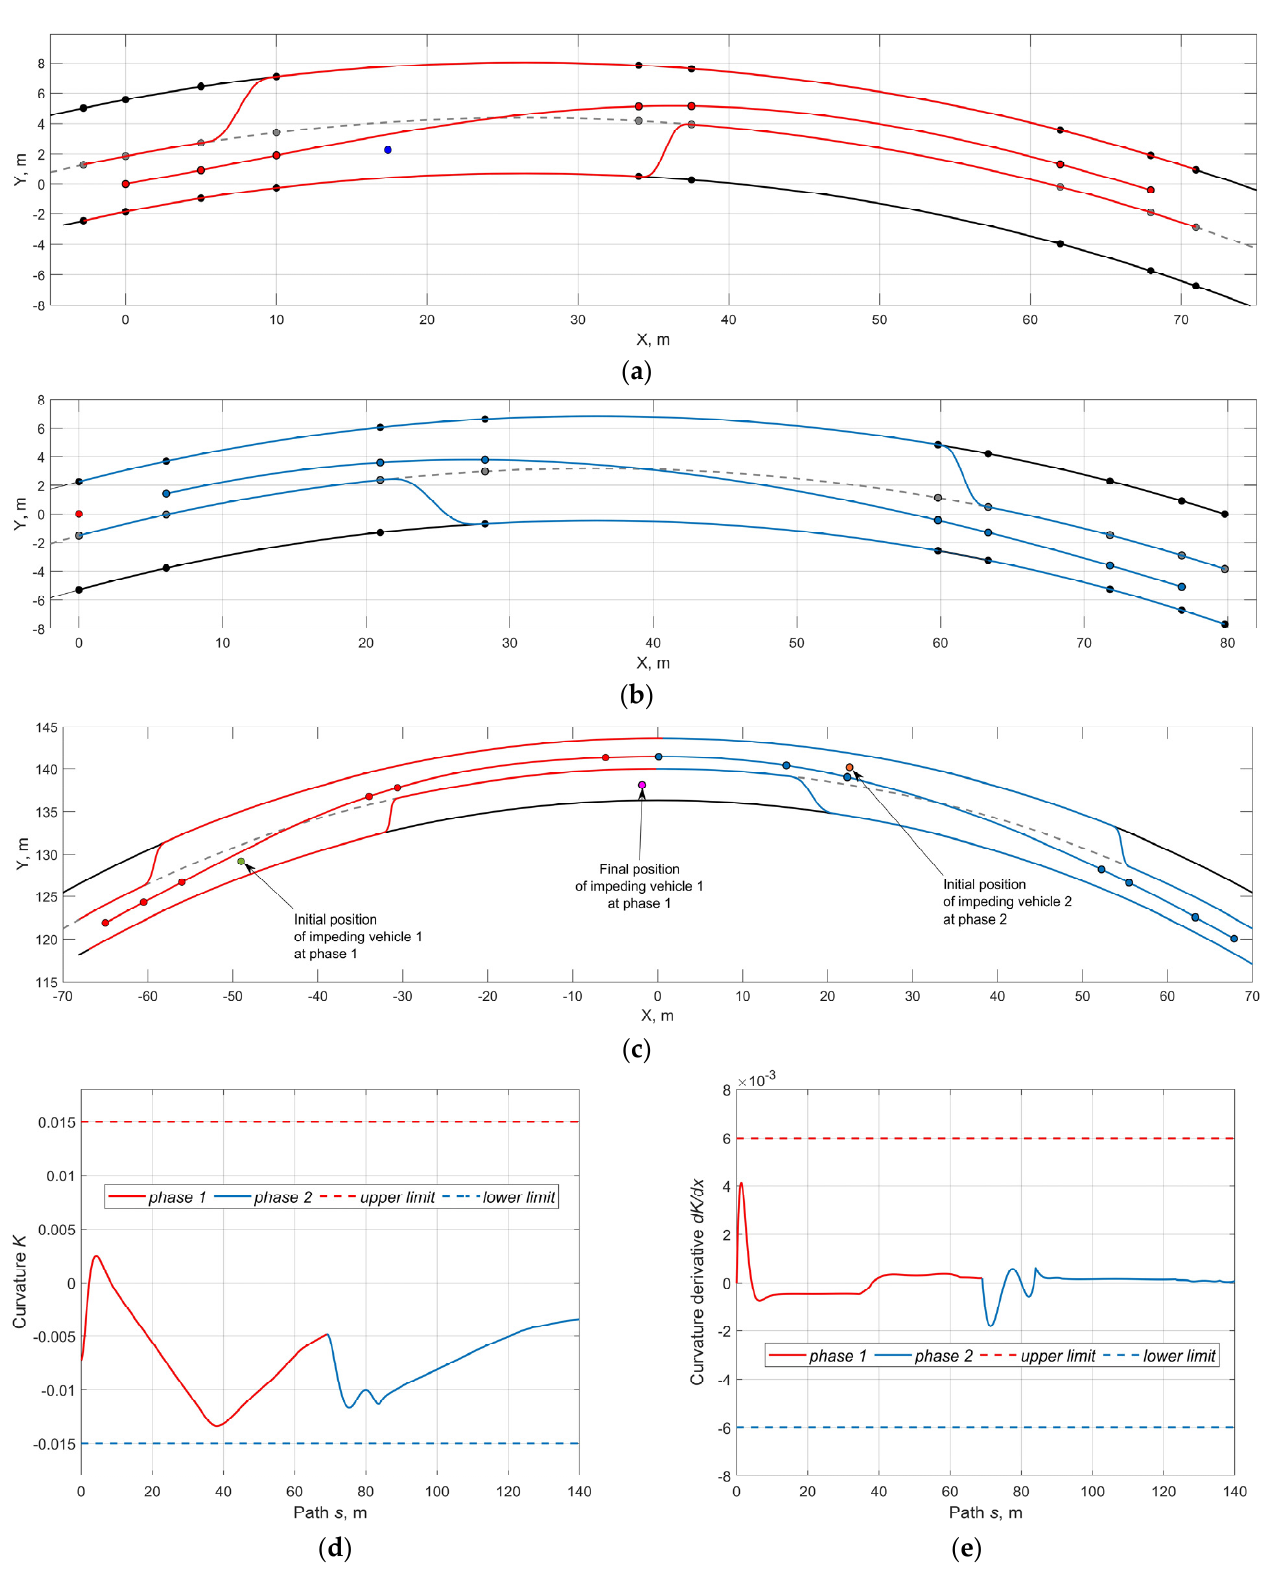
Figure 7. Optimized trajectories according to the motion stages: ( a )—first phase; ( b )—second phase; ( c )—joined phases; ( d )—curvature; ( e )—curvature